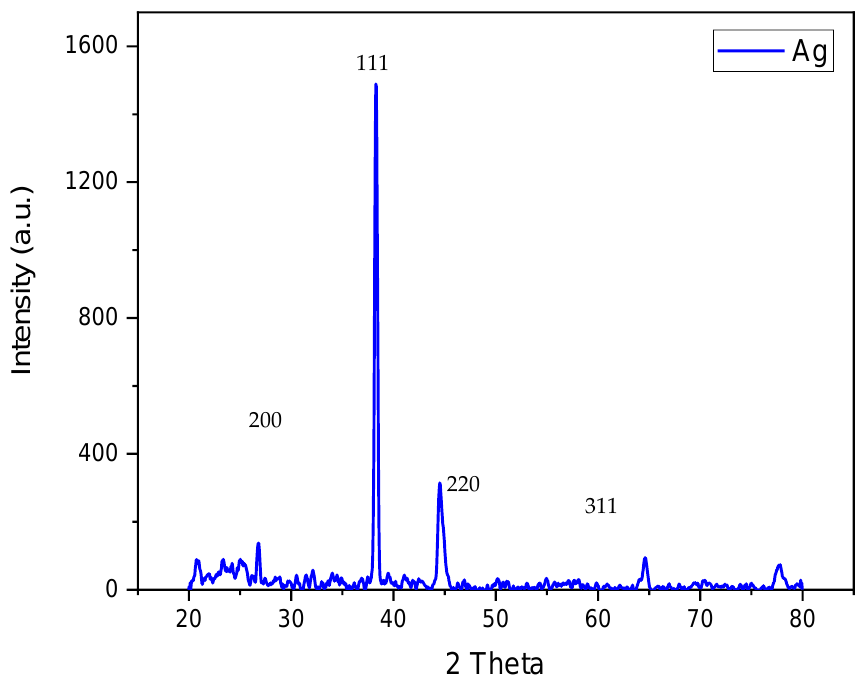
Figure 6. X-ray diffraction analysis of green-synthesized silver nanoparticles. The crystalline structure of biologically synthesized Ag-NPs using Aloe vera , coriander, mint, and lemongrass extract was analyzed via XRD measurements. A typical XRD pattern of the Ag was found by Bragg reflections corresponding to (111), (200), (220), and (311) sets of lattice planes that could be indexed on the bases of the FCC structure of silver. The weak intensities of peaks indicate that the silver nanoparticles were placed on a thin film for the XRD measurements.